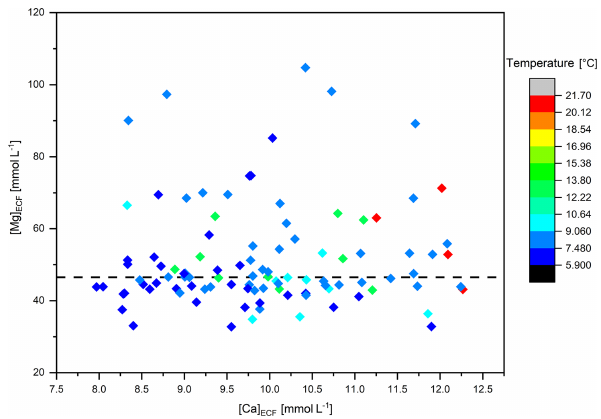
Figure 7. Calcium and Magnesium concentration in the ECF of the investigated corals. The color of the data points indicates the ambi- ent water temperature, which increases with increasing Ca concen- trations. The dashed line indicates the median of the Mg concentra- tion in the